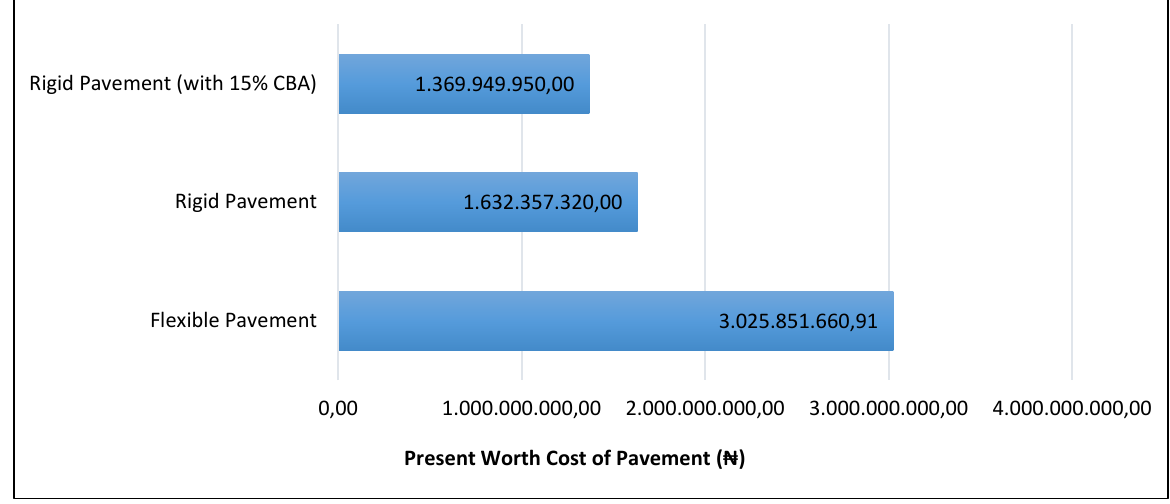
Figure 3: Present worth cost for the varying pavement